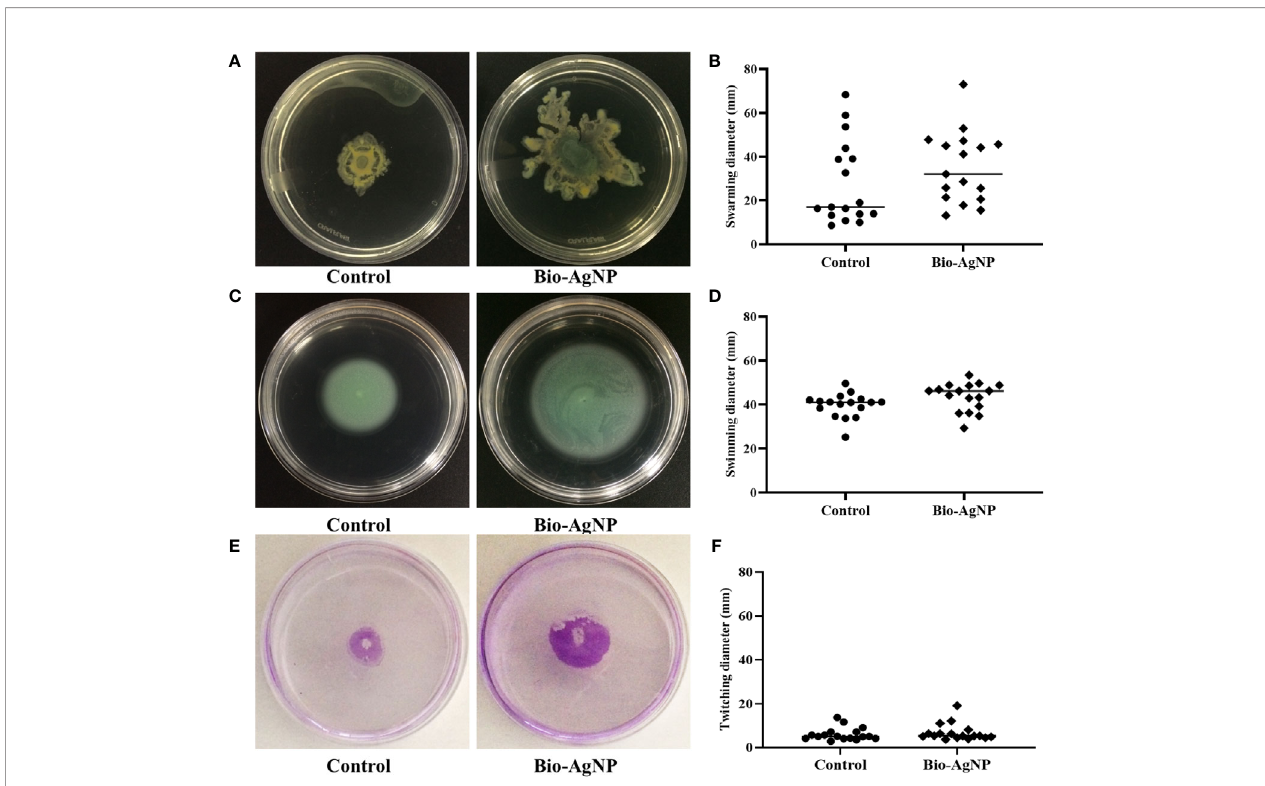
FIGURE 3 | Pseudomonas aeruginosa motility in the absence (control) and presence of biogenic silver nanoparticles (bio-AgNPs). (A) Swarming motility of P2 isolate, (B) mean swarming motility, (C) swimming motility of P2 isolate, (D) mean swimming motility, (E) twitching motility of P6 isolate, and (F) mean twitching